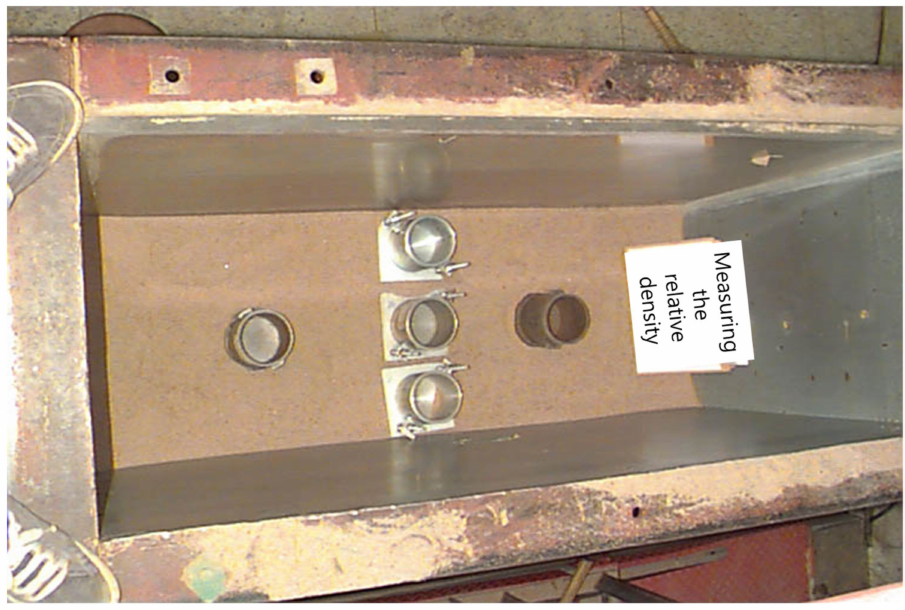
Figure 4. Setting up the molds for measuring the relative density.